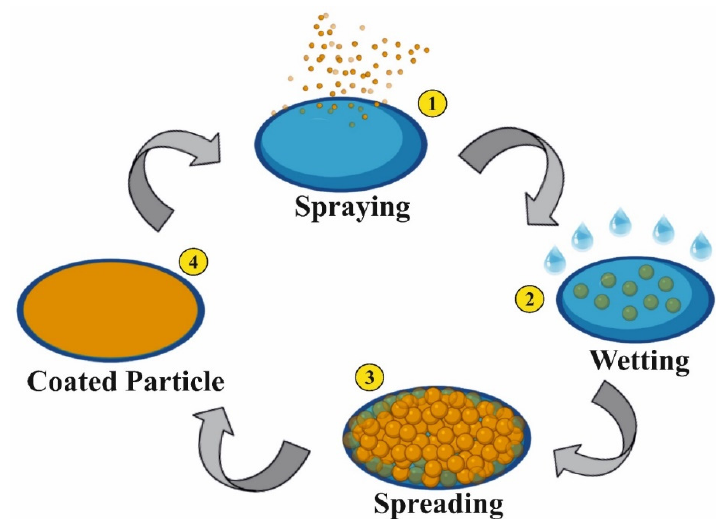
Figure 3. Mechanism of microencapsulation.